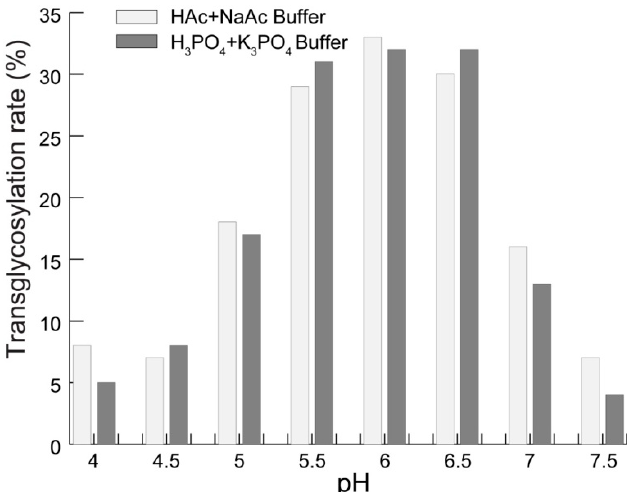
Figure 3. Transglycosylation rate affected by